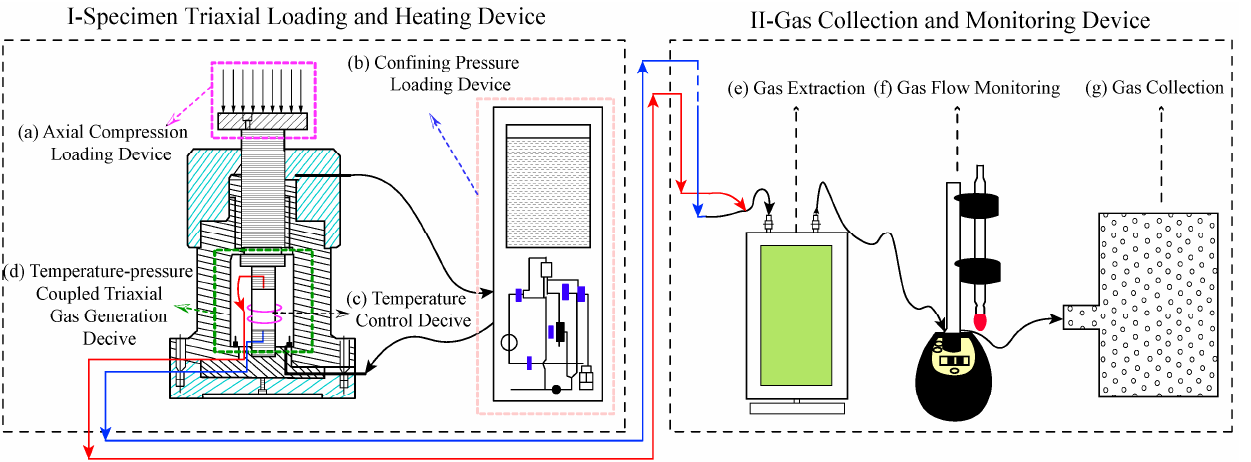
Figure 1. Schematic diagram of gas production measurement system of coal-rock under temperature–pressure coupling.